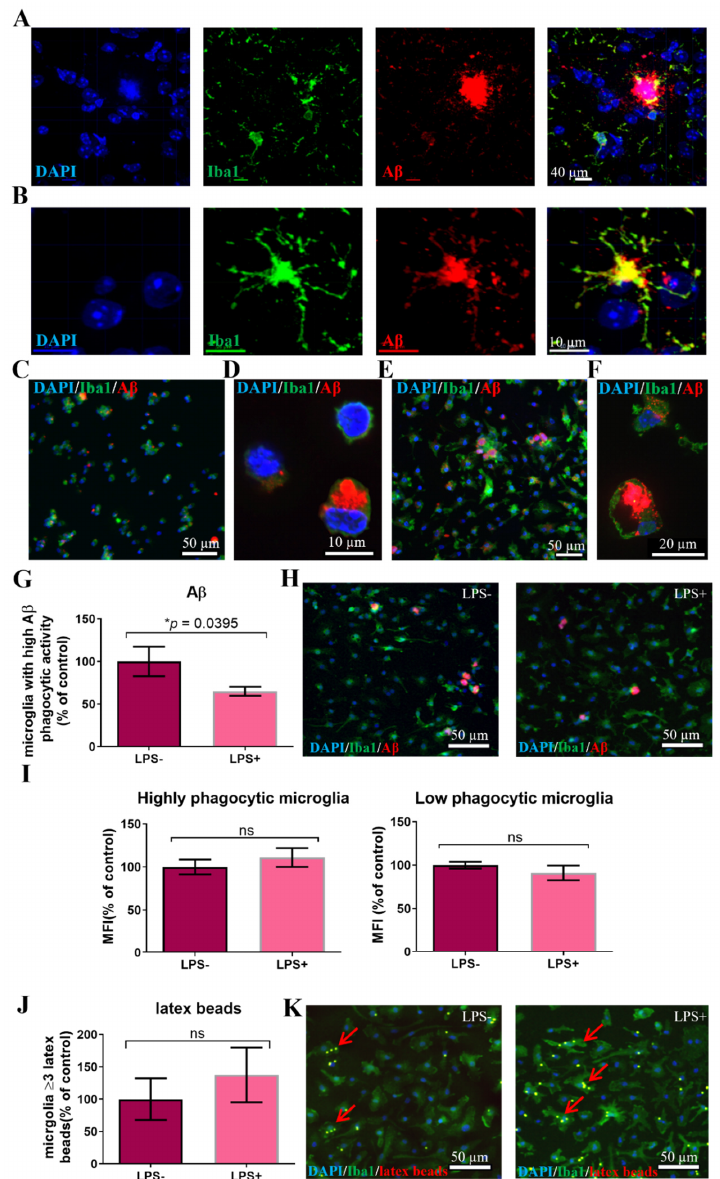
Figure 2. Characterization of A β uptake by microglia. ( A ) Immune-fluorescent staining of brain sections from 7-month-old 5XFAD mouse (Bregma AP = 0) for A β and Iba1+ cells show the presence of amyloid plaques surrounded by microglia. ( B ) High resolution microscopy of stained brain section shows microglia with massive intracellular A β accumulation. ( C ) Freshly isolated microglia from 7-month-old 5xFAD mice show varying amounts of intracellular A β . ( D ) A subpopulation of microglia from 7-month-old 5xFAD mice shows massive intracellular A β content. ( E ) Isolated microglia that were fed with fluorescent A β displayed varying levels of A β uptake; 5–10% of microglia exhibited high A β phagocytic activity. ( F ) Higher resolution shows microglia with low versus high A β phagocytic activity. ( G ) Incubation of microglia with LPS induced a decrease in the microglial subpopulation with high phagocytic activity of A β . Student t -test * p = 0.0395. ( H ) Representative images of microglial uptake of A β in the absence and presence of LPS. ( I ) A β amount per cell (by mean fluorescence intensity) did not change in response to LPS activation in either microglial populations with high or low A β phagocytic activity. ( J ) Incubation of microglia with LPS induced a non-significant increase in the fraction of microglia with ≥ 3 latex beads. ( K ) Representative images of microglial uptake of latex beads in the absence and presence of LPS. Blue = DAPI, green = Iba1, red = A β /latex beads, ns = non-significant, MFI = mean fluorescent intensity, scale = 50 µ